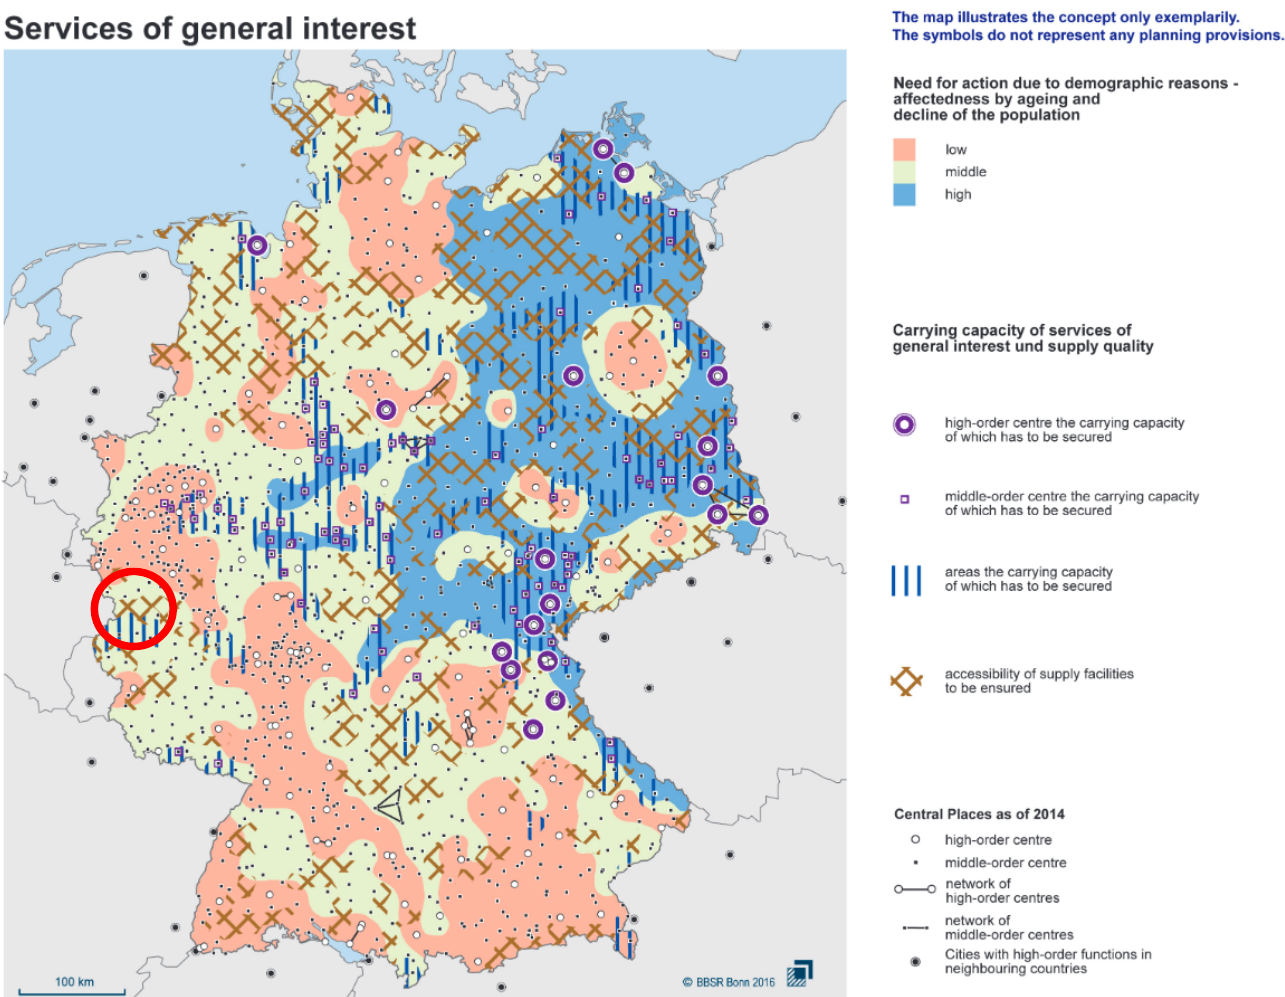
Figure 1. SGI in Germany [9] (p. 20). Reprinted with permission from Ref. [9]. 2016, BBSR.